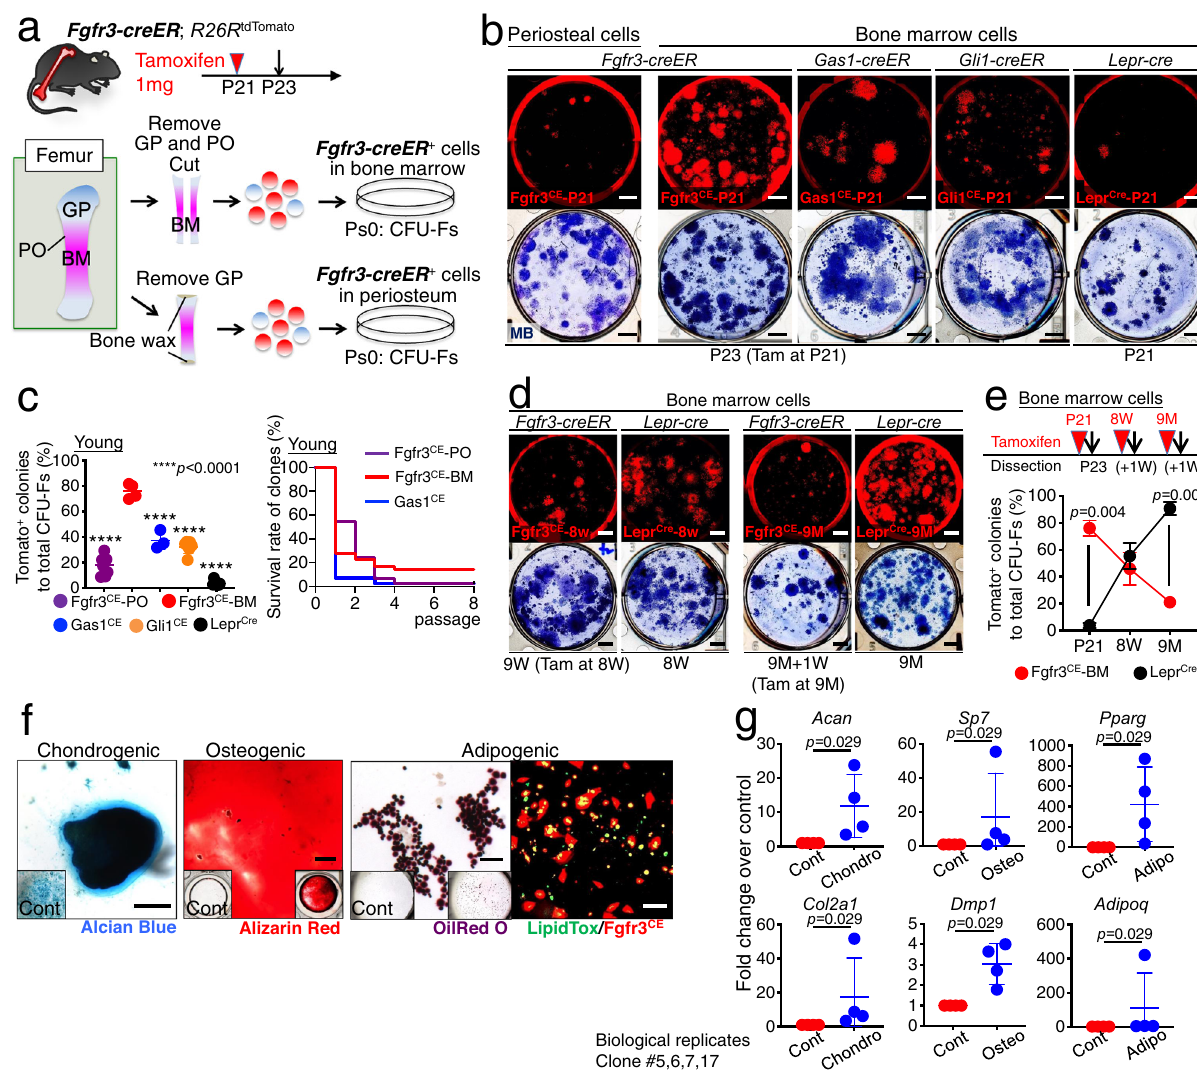
Fig.3|Fgfr3 + endostealstromalcellsareenrichedforskeletalstemcellactivity. a Diagram of protocols to isolate Fgfr3-creER + cells from bone marrow (top) or periosteum (bottom). b CFU-F assay. Fgfr3 CE -tdTomato + periosteal cells (leftmost), Fgfr3 CE -tdTomato + (left center), Gas1 CE -tdTomato + (center), and Gli1 CE -tdTomato + (right center) bone marrow cells at P23 (pulsed at P21), and Lepr cre -tdTomato + (rightmost) bone marrow cells at P21. Upper: tdTomato + colonies, Lower: total colonies stained by methylene blue. Scale bar: 5mm. c Percentage of tdTomato + coloniesamongtotalCFU-Fsinyoungbone(left).Fgfr3 CE -periosteum,Fgfr3 CE -bone marrow, Gas1 CE , Gli1 CE and Lepr cre . n =8 (Fgfr3 CE -periosteum), n =4 (Fgfr3 CE -bone marrow), n =3 (Gas1 CE ), n =7 (Gli1 CE ), n =8 (Lepr cre ) mice. Two-tailed, one-way ANOVA followed by Dunnett ’ s multiple comparison test. Survival curve of indivi- dual tdTomato + clones over serial passages (right). n =46 (Fgfr3 CE -periosteum), n =25 (Fgfr3 CE -bone marrow), n =41 (Gas1 CE ) clones. Log-rank (Mantel – Cox) test. d CFU-F assay of Fgfr3 CE -tdTomato + bone marrow cells at 1 week after the pulse at 8Wor9M,andLepr cre -tdTomato + bonemarrowcellsat8Wand9M.Scalebar:5mm.